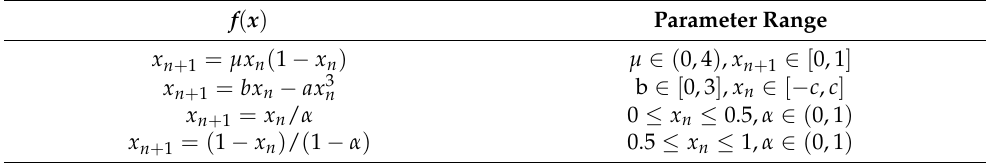
Table 1. Chaotic mappings and parameter